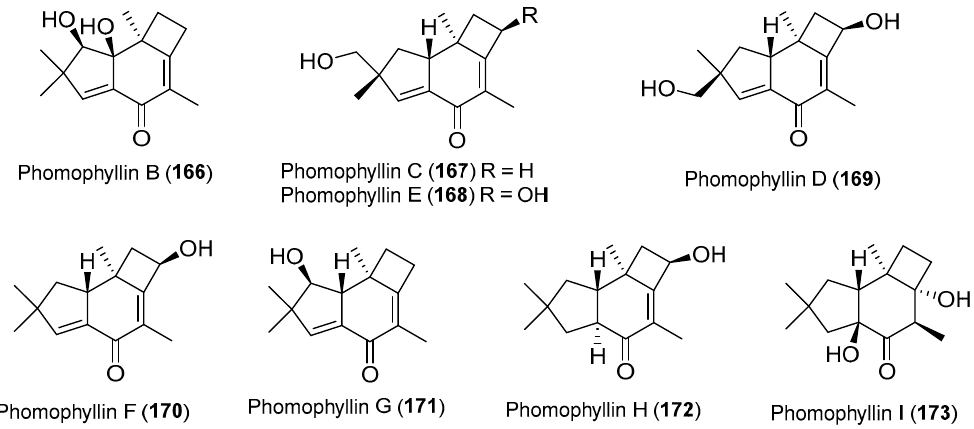
Figure 26. Structures of phomophyllins B–I ( 166 – 173 ) isolated from Phomopsis sp.